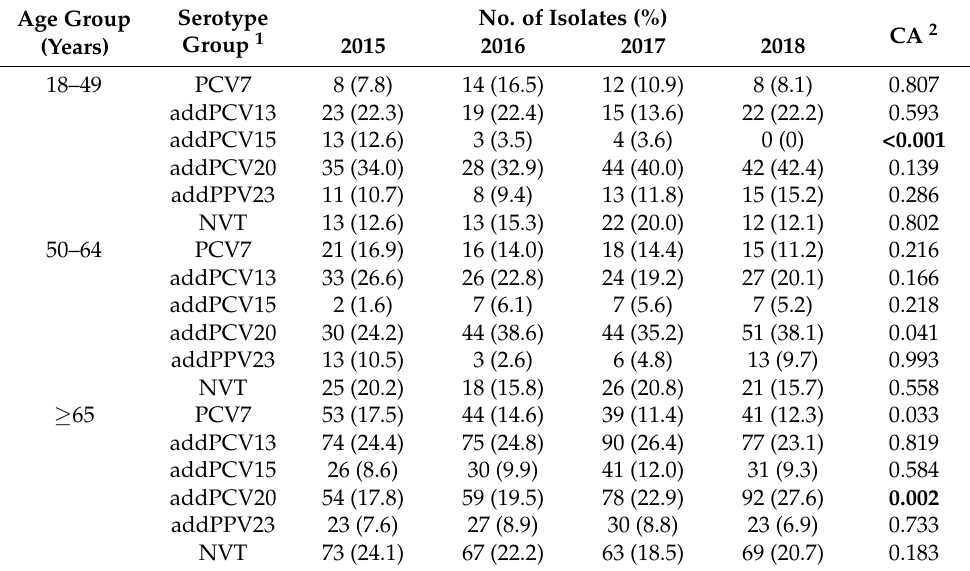
Table 3. Number of isolates responsible for invasive pneumococcal disease in adult patients, accord- ing to vaccine serotype groups and age groups, from 2015 to